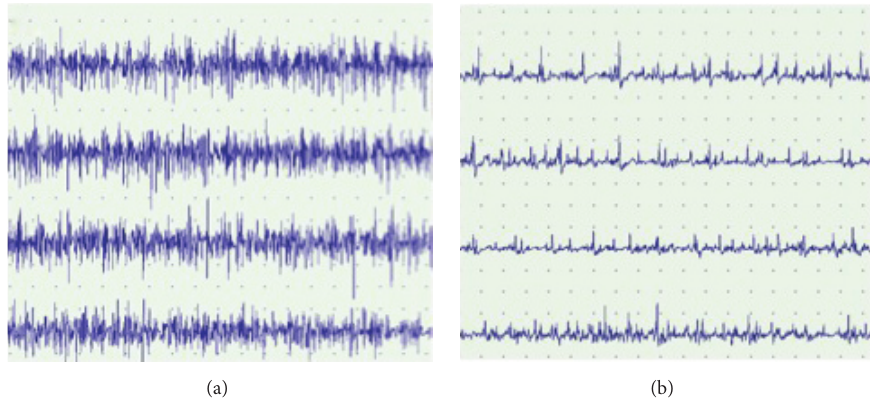
Figure 1: EMG of EO muscles of both sides during MVMC in a patient with PS bending to the right side. (a) Interferential pattern in the right EO muscle during MVMC. (b) Subinterferential pattern in the left EO muscle during MVMC. EMG: electromyography; EO: external oblique muscle; MVMC: maximal voluntary muscle